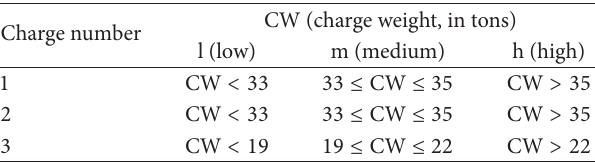
Table 2: Algorithm for choosing charge identifiers based on charge